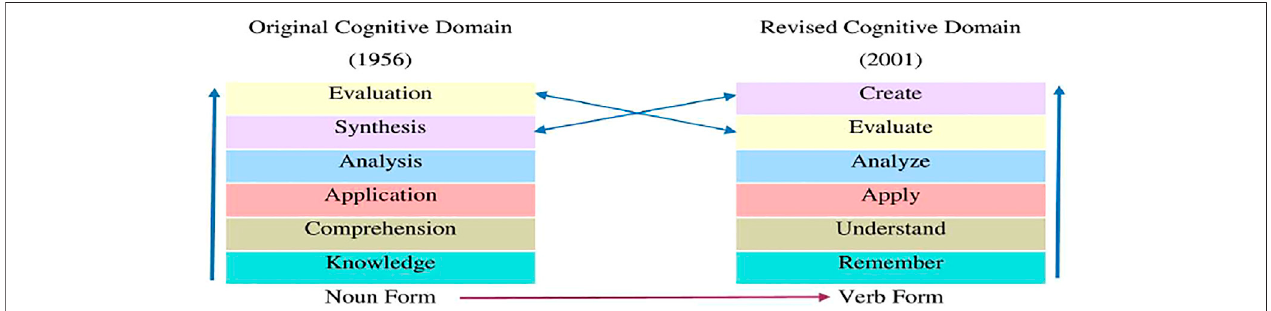
FIGURE 1 | Variances between original cognitive and revised domains.